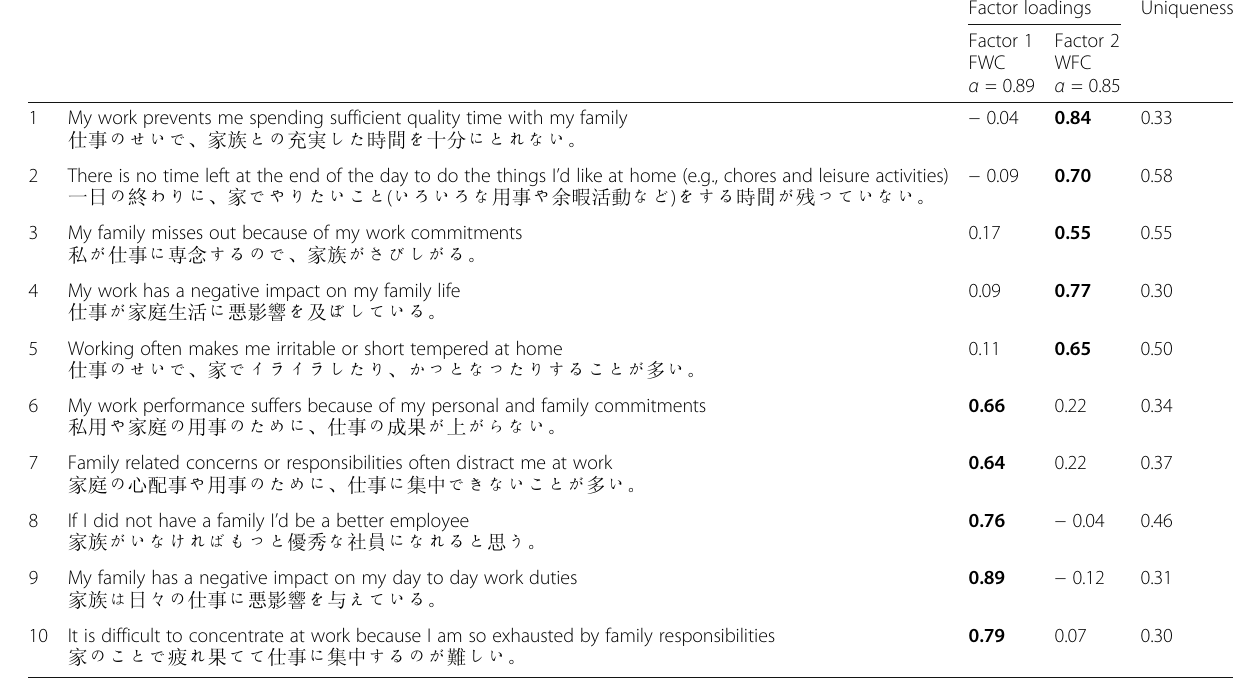
Table 4 Results of the exploratory factor analysis for the Japanese version of the Work – Family Conflict Scale with promax